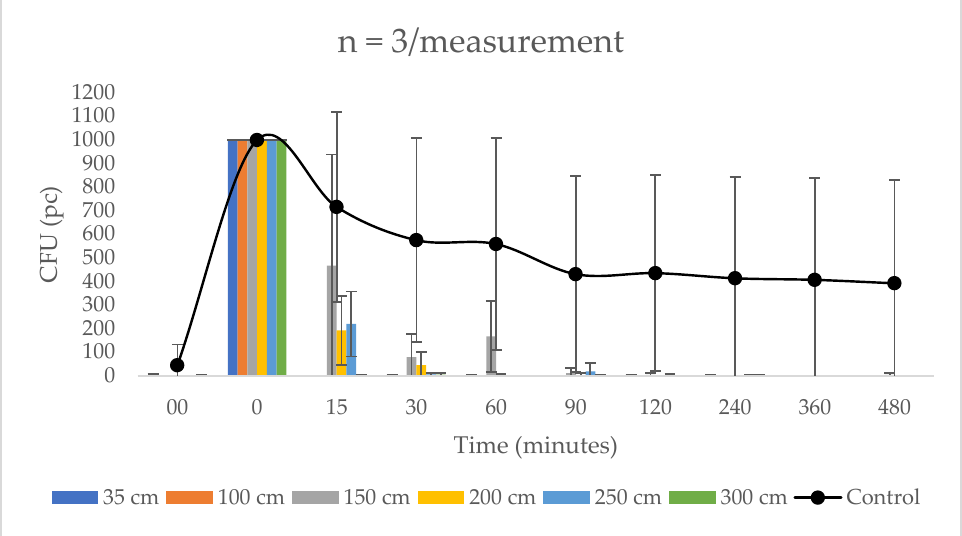
Figure 1. The efficiency of a 4 W light source at each treatment distance compared to the untreated surface. The rate of decrease in the CFU count of a photocatalyst coating-treated surface as a function of time for a 4 W LED lamp at different distances compared to the average CFU count of untreated (Control) surfaces. Starting from 90 min, the bacterial count reduction is 99.5%. As shown in the statistical analysis, power wattage did not affect overall efficacy. a distance of 250 cm. resulting in 99.7% reduction after 60 min.